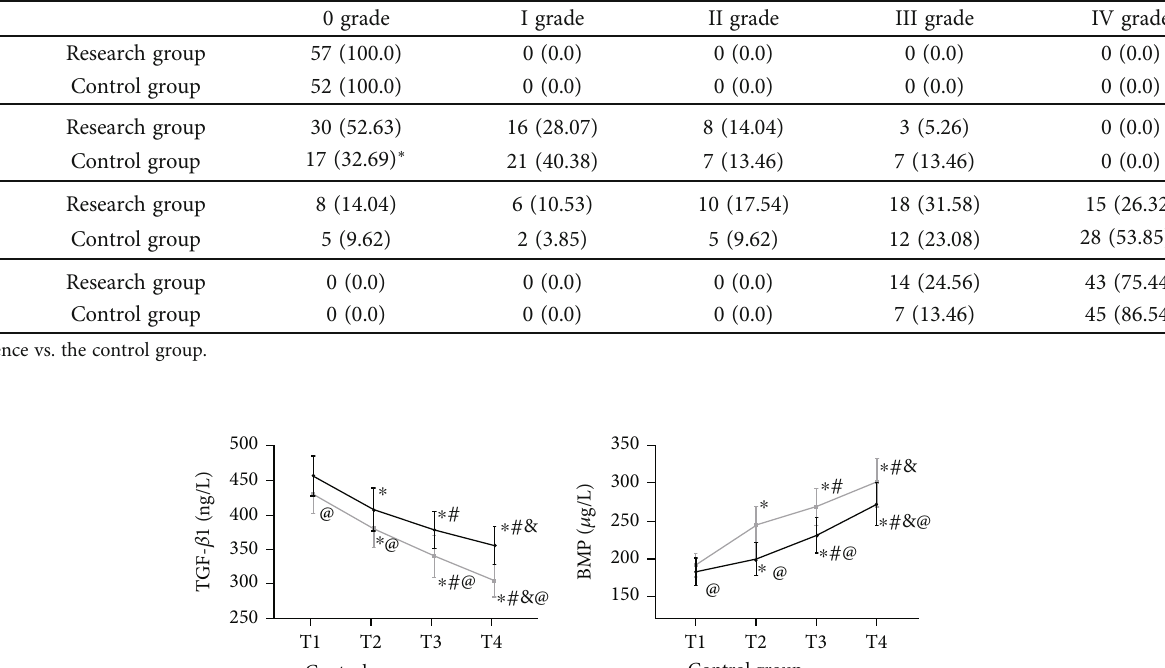
Table 4: Comparison of maturation ability of granulation tissue.